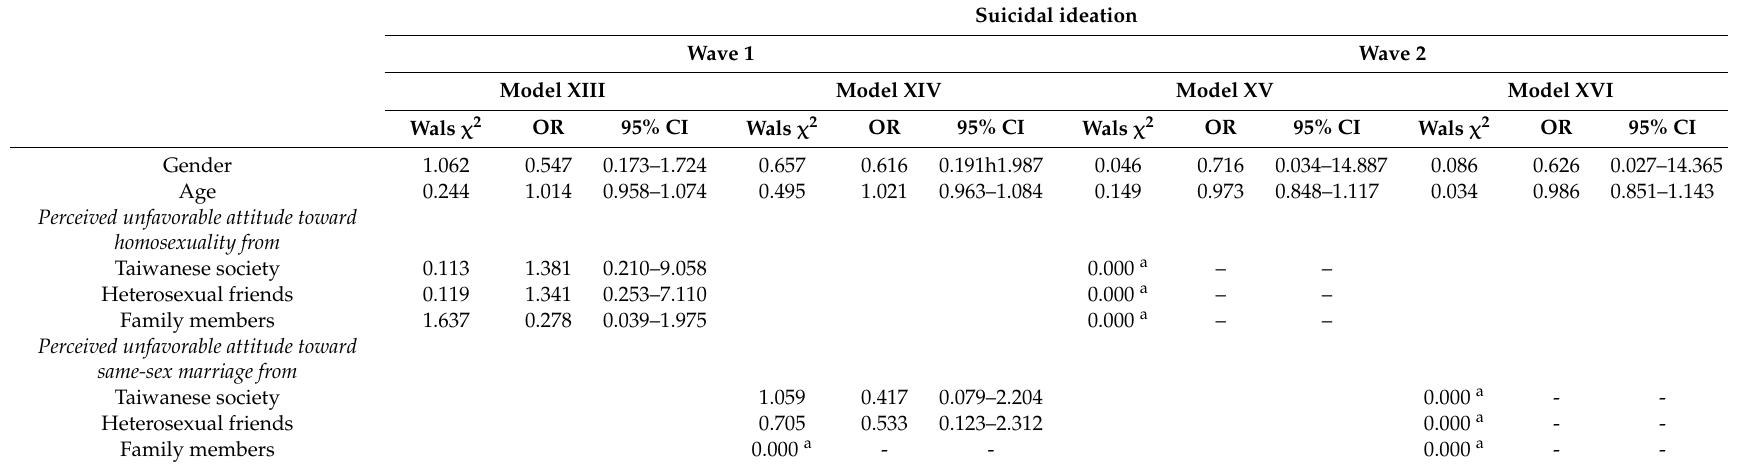
Table 5. Association of perceived unfavorable attitudes toward homosexuality and same-sex marriage from Taiwanese society, heterosexual friends, and family members with suicidal ideation in heterosexual participants with an unfavorable attitude toward